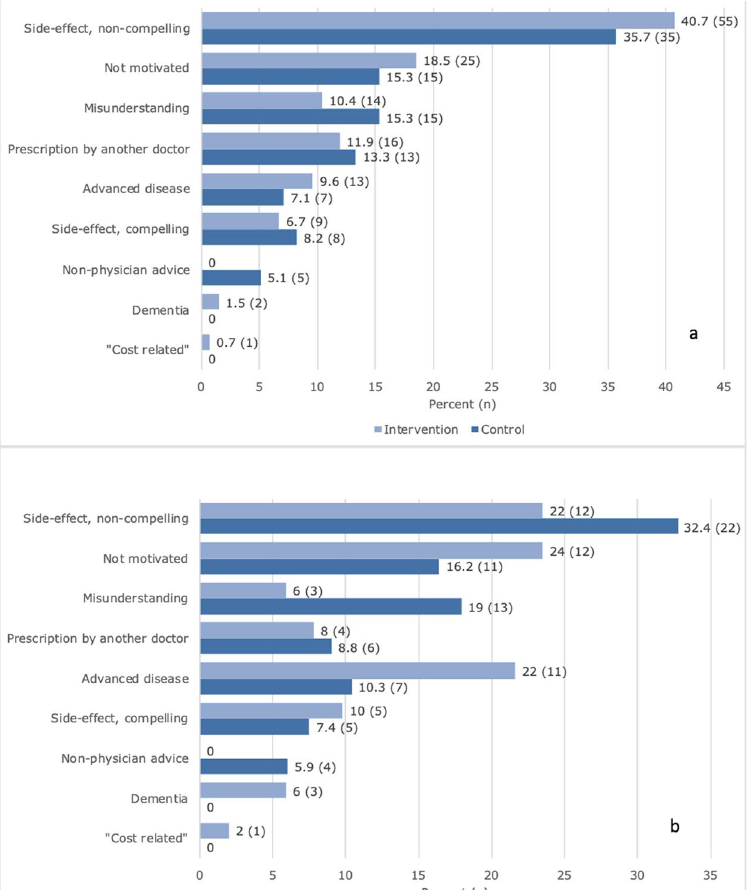
Figure 4. Reasons for discontinuation. ( a ) first discontinuation; ( b ) permanent discontinuation. Presented group-wise. Patients that never initialised statin treatment are